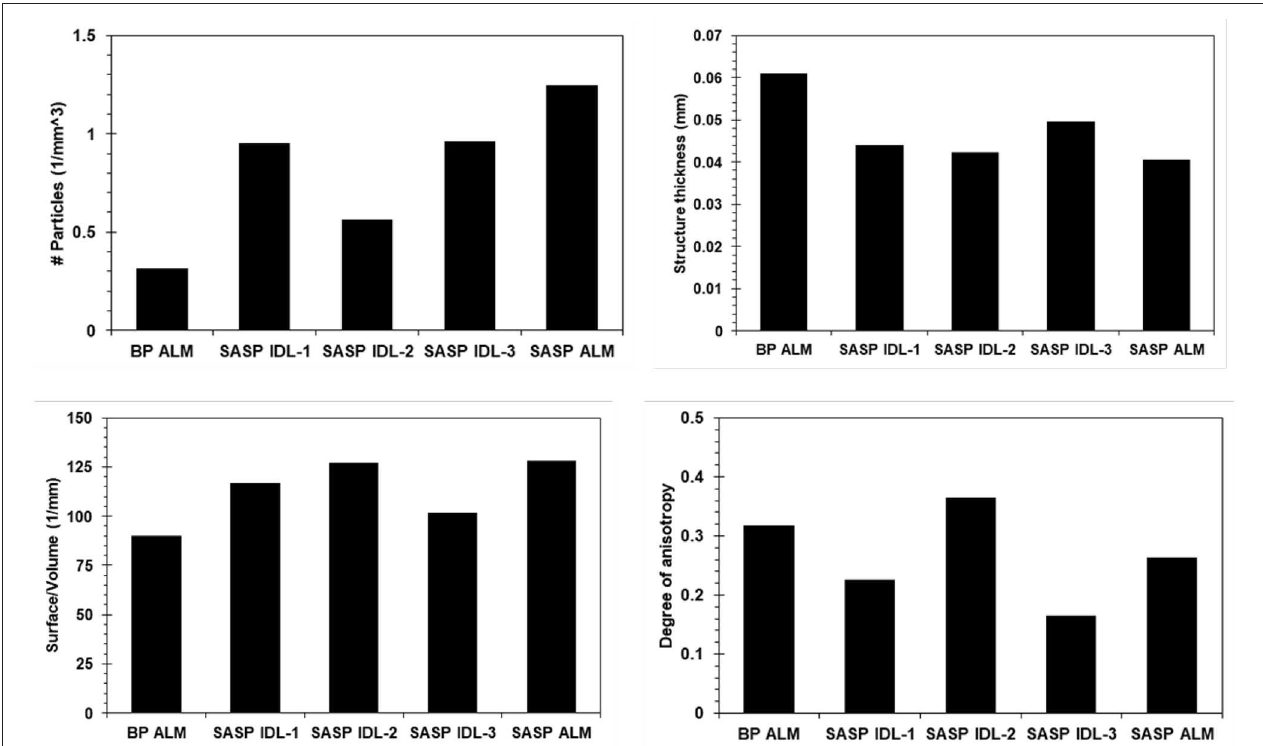
FIGURE 4 | Microstructural characterization of the dust particles in snow samples from Berthoud Pass and Swamp Angel Study Plot BP ALM (Berthoud Pass, all layers merged), SASP IDL (Swamp Angel Study Plot individual dust event layer, subsamples 1–3), and SASP ALM (Swamp Angel Study Plot all layers merged). The top panels show the number of particles per cubic millimeter and average thickness of the particles for all five samples containing noticeable quantities of dust. The bottom panels show the surface to volume ratio and degree of